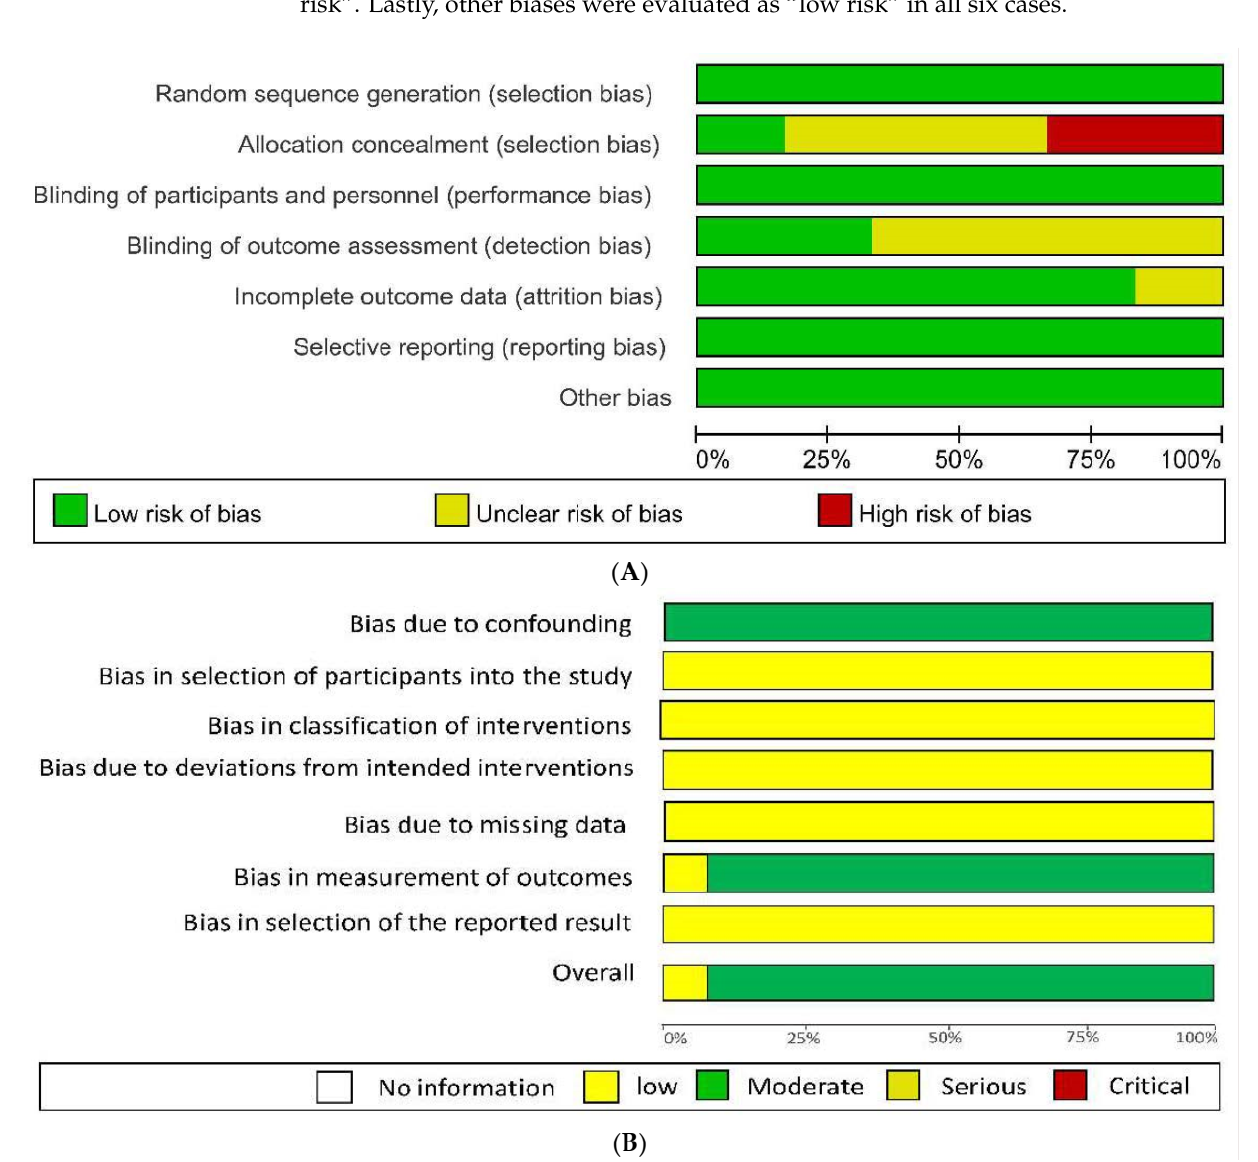
Figure 3. Risk of bias. ( A ) Risk of Bias assessment tool for randomized study graph, ( B ) risk of bias assessment tool for non-randomized study